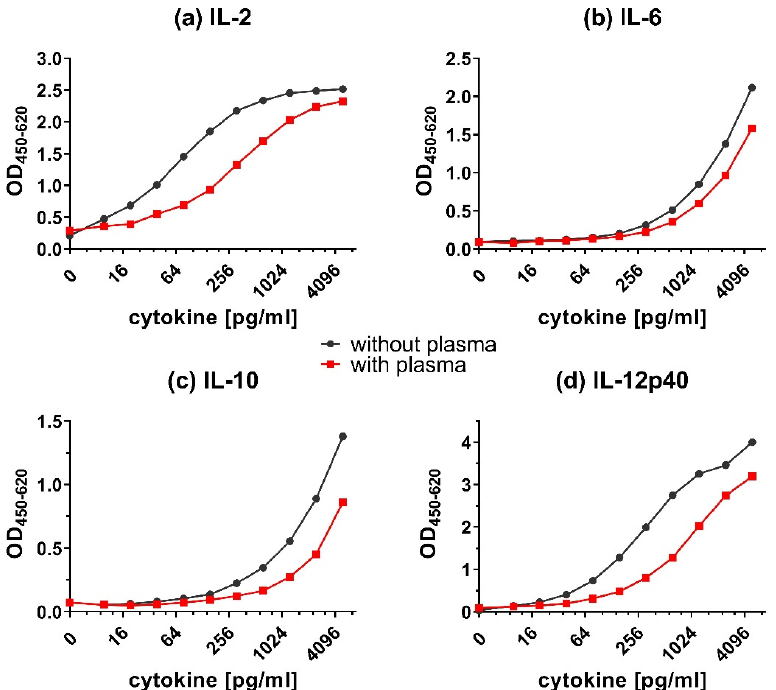
Figure 5. Matrix effect on the detection of cytokines in presence of plasma. Calibration curves for ( a ) IL-2, ( b ) IL-6, ( c ) IL-10, and ( d ) IL-12p40 in dilution buffer with or without plasma. The capture ELISA was performed with a range of 9.8–5000 pg/mL of recombinant cytokines in dilution buffer (1.5% BSA in PBS) only (without plasma) or containing additional chicken plasma (with plasma).